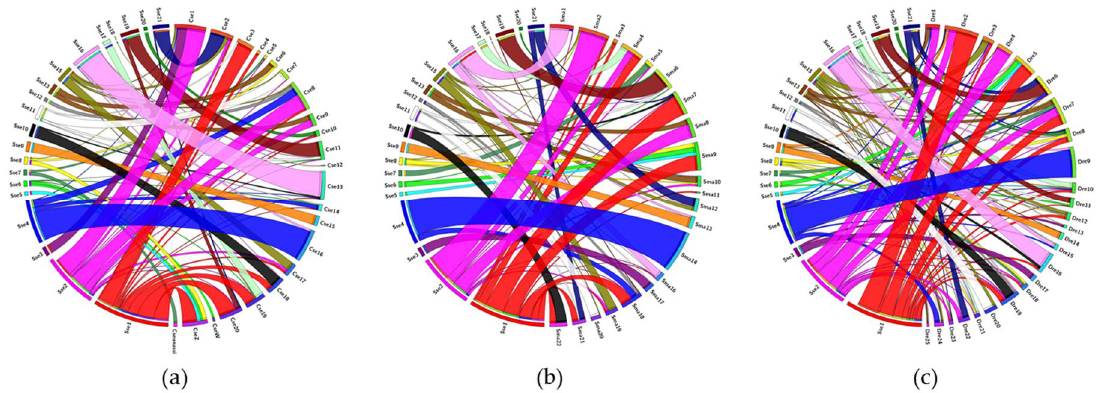
Figure 5. Circos diagrams between the BAC clones located on the chromosomes of Solea senegalensis and the orthologues on the chromosomes of ( a ) Cynoglossus semilaevis , ( b ) Scophthalmus maximus and ( c ) Danio rerio . The comparison between S. senegalensis and D. rerio also allowed us to identify large